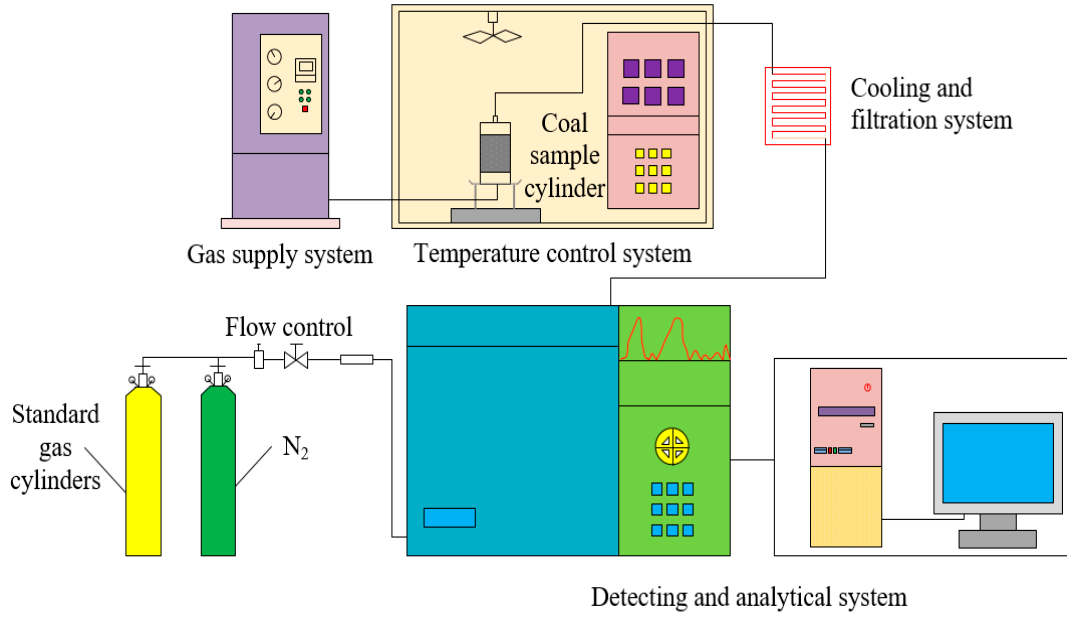
Figure 2. Schematic diagram of apparatus applied for temperature programmed oxidation of coals.